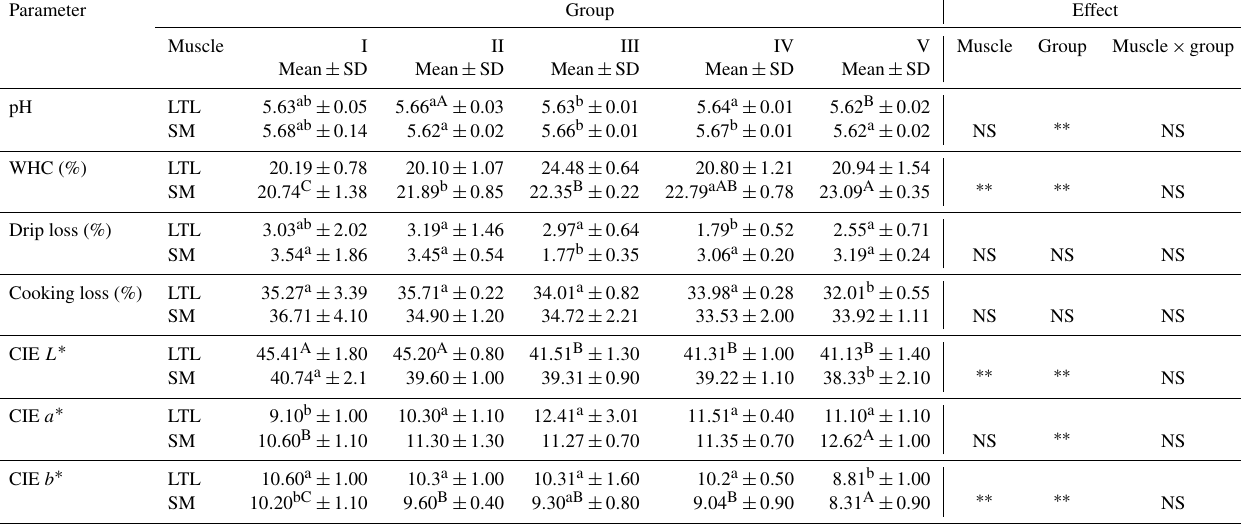
Means in the same row with different letters are significantly different: a , b P ≤ 0 . 05 ; A , B , C P ≤ 0 . 01 . LTL: M. longissimus thoracis et lumborum; SM: M. semimembranosus; WHC: water holding capacity. Group I – 30 ± 5 kg; group II – 45 ± 4 . 9 kg; group III – 60 ± 4 . 7 kg; group IV – 75 ± 5 . 2 kg; group V – 90 ± 5 . 0